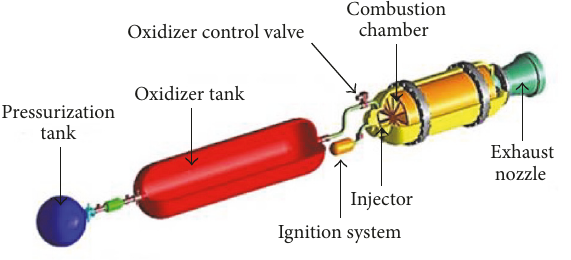
Figure 1: Classic hybrid